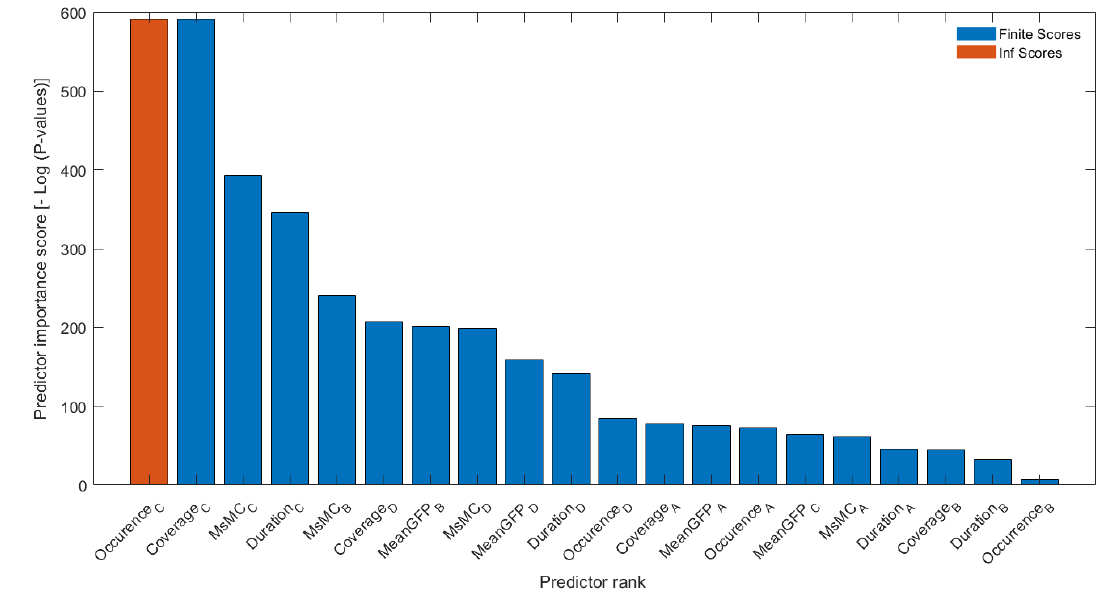
Figure 2. Four normalized microstates (i.e., A, B, C, and D) of resting-state EEG recordings were obtained for patients diagnosed with schizophrenia and healthy control subjects; SZ: patients diag- nosed with schizophrenia; HC: healthy control subjects.